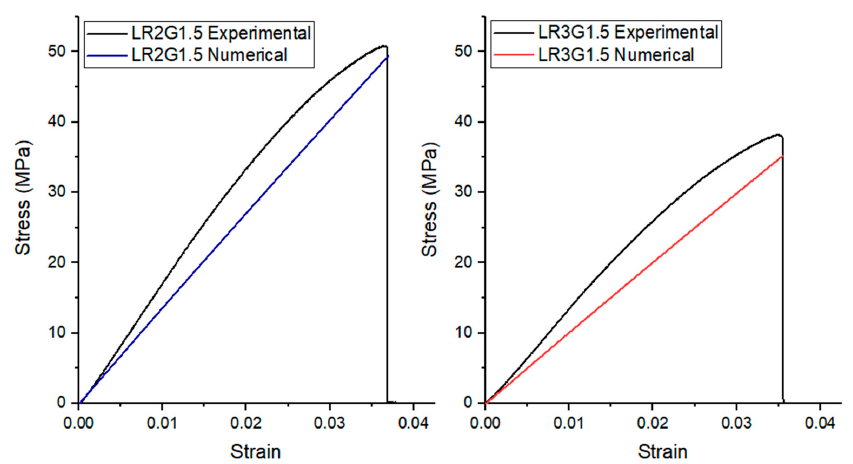
Figure 6. Comparison of the experimental results and FEM analyses.